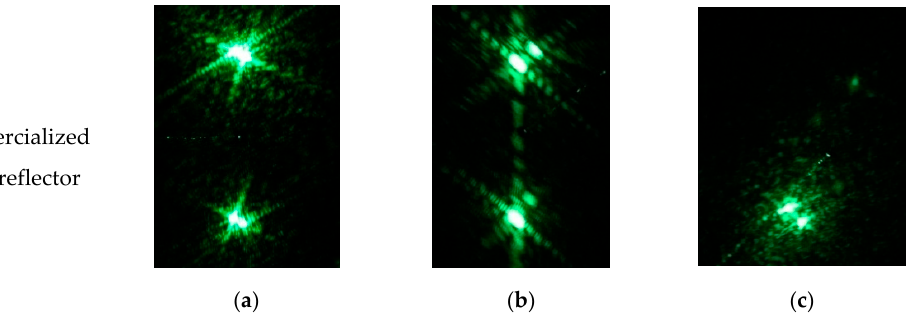
Figure 9. The retro-reflected outputs by ( a ) anterior, ( b ) central, and ( c ) posterior regions of the commercial SuperPin CCCR.